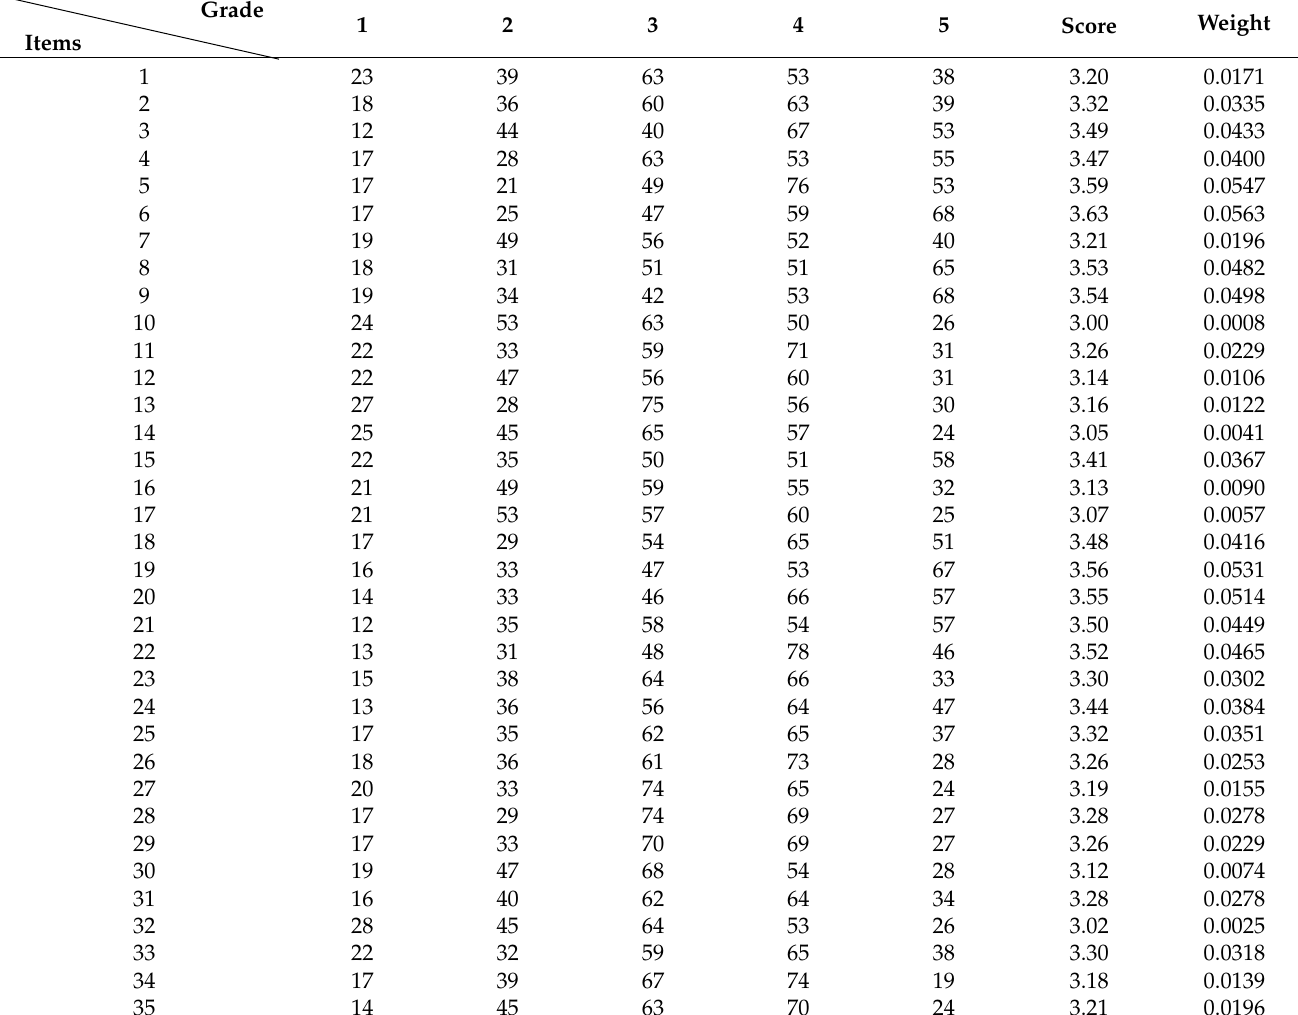
Table A3. Questionnaire score and weight